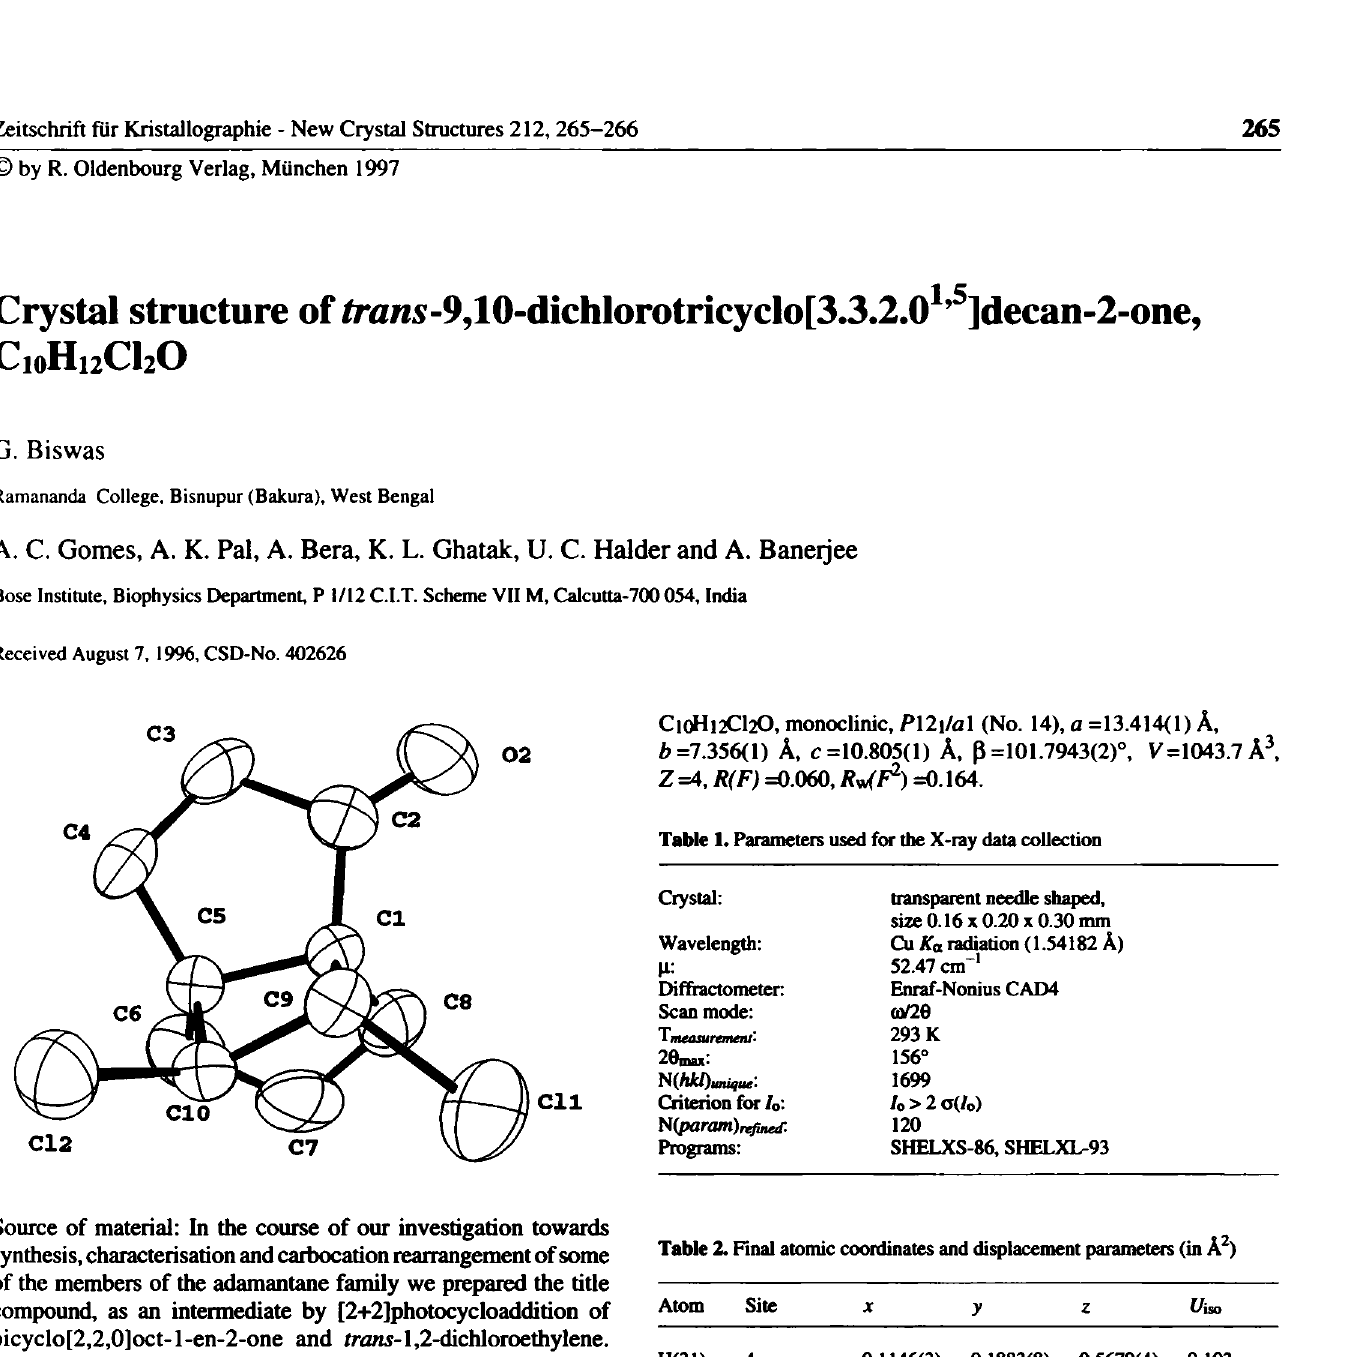
Table 3. Final atomic coordinates and displacement parameters (in Â 2